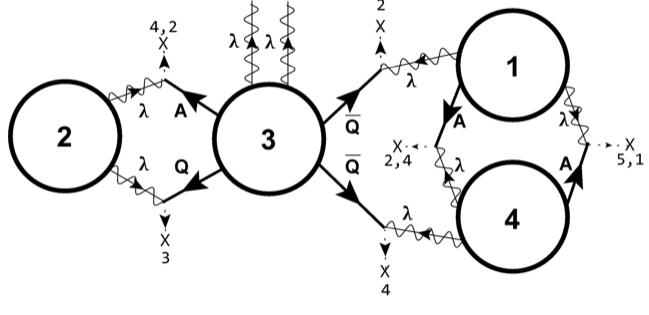
Figure 10: The multi-monopole composite contributing to the superpotential for F = 1 when the gauge group breaks from SU ( 5 ) to SU ( 2 ) and squark VEVs, (61) and (81), are represented as a cross with their color